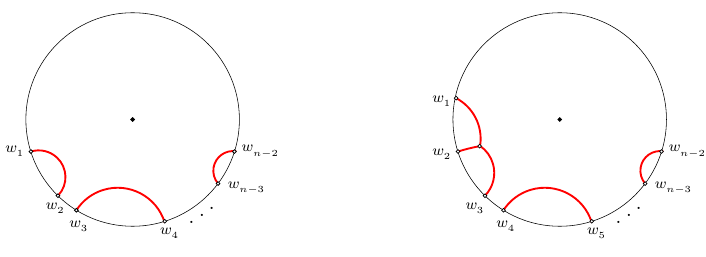
Figure 10 . Vacuum blocks with odd n .